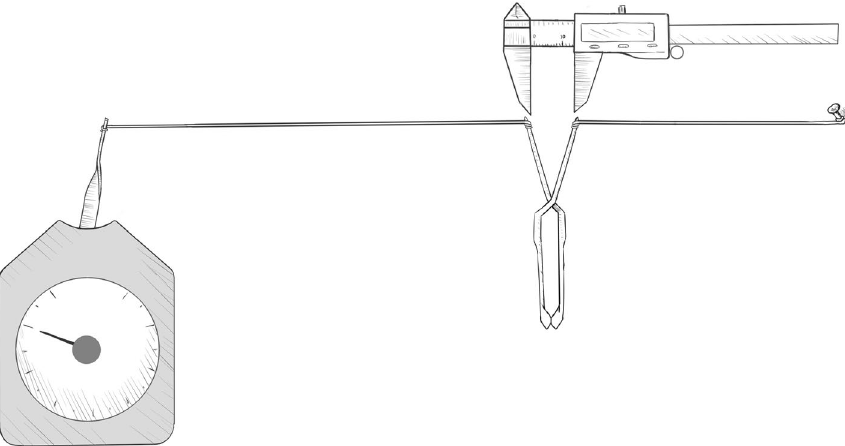
Figure 3. Schematic Diagram of Device for Measuring Occlusive Force of Blood Vessel Clamp. One third of each of the blades of the blood clamp was fixed with 4–0 silk threads, one side being fixed to the dynamometer sensing rod, and the other to the experiment table. The vascular clamp was then slowly pulled apart until the blade opening width was the same as the measured vascular diameter, and the required force, namely the occlusive force of the vascular clamp at the time, was recorded. (Adobe Photoshop: 21.0.1 20,191,106.r.47 2019/11/06:3152b481f18 × 64 https ://www.adobe .com/cn/produ cts/photo